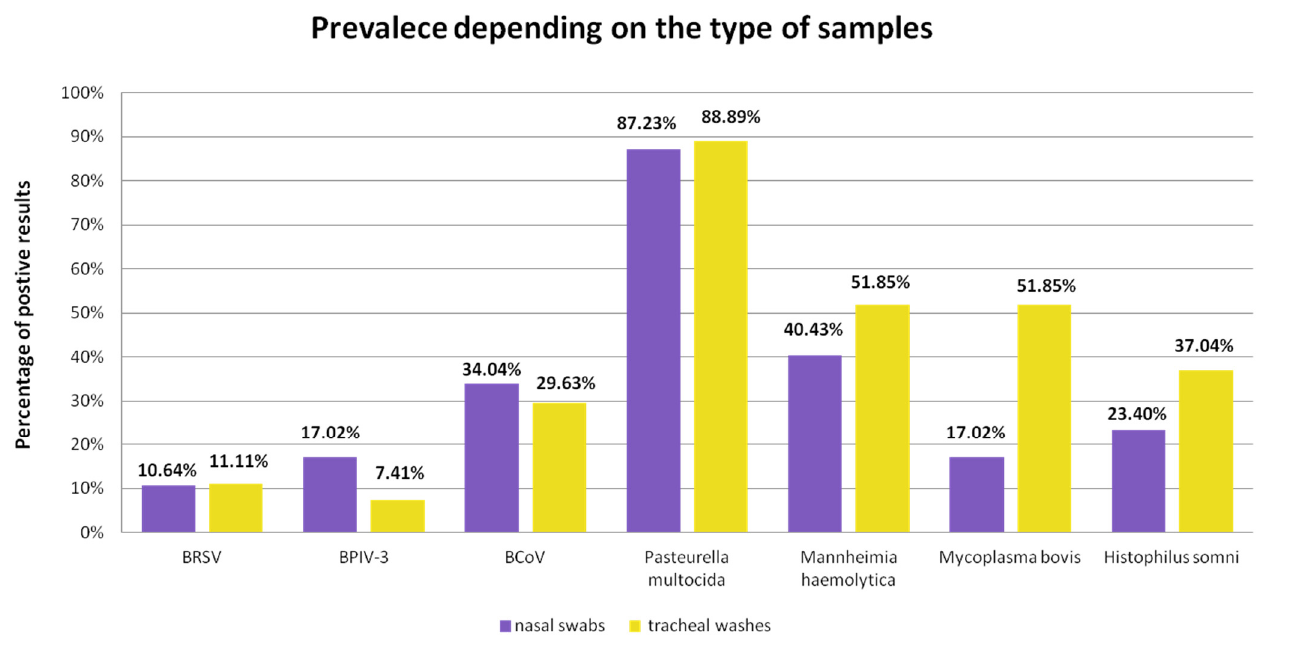
Figure 4. The prevalence of individual pathogens detected depending on the type of sample.